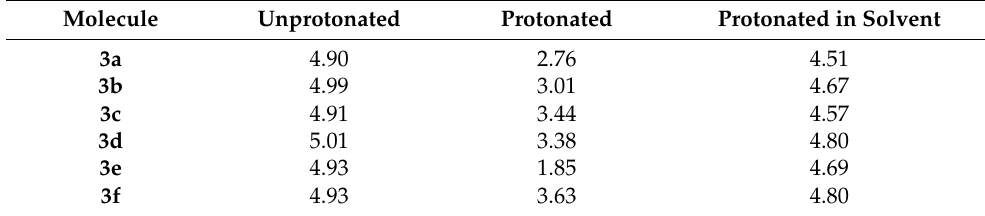
Table 8. ∆ E (eV) values for the inhibitors in vacuum unprotonated, fully protonated, and fully protonated in solvent.